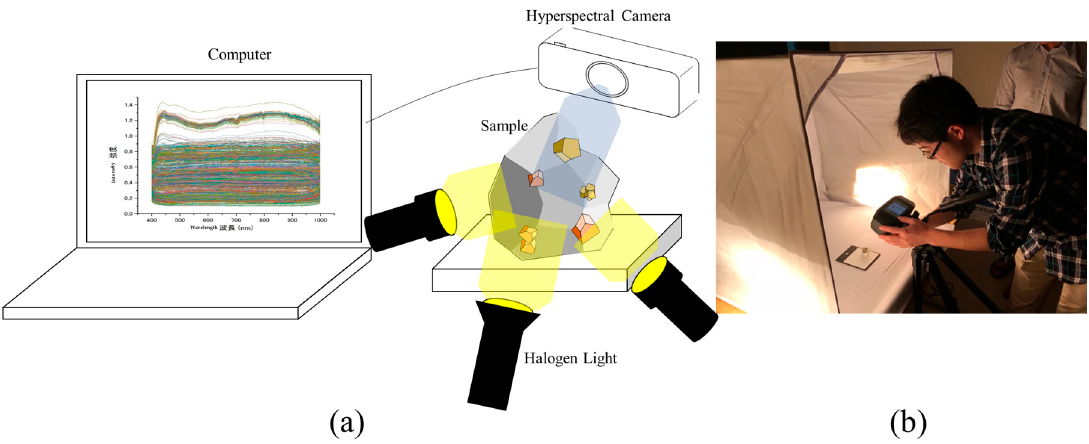
Figure 6. Arrangement of the experiment: ( a ) schematic diagram of experiment, and ( b ) photo of the set-up of experiment.